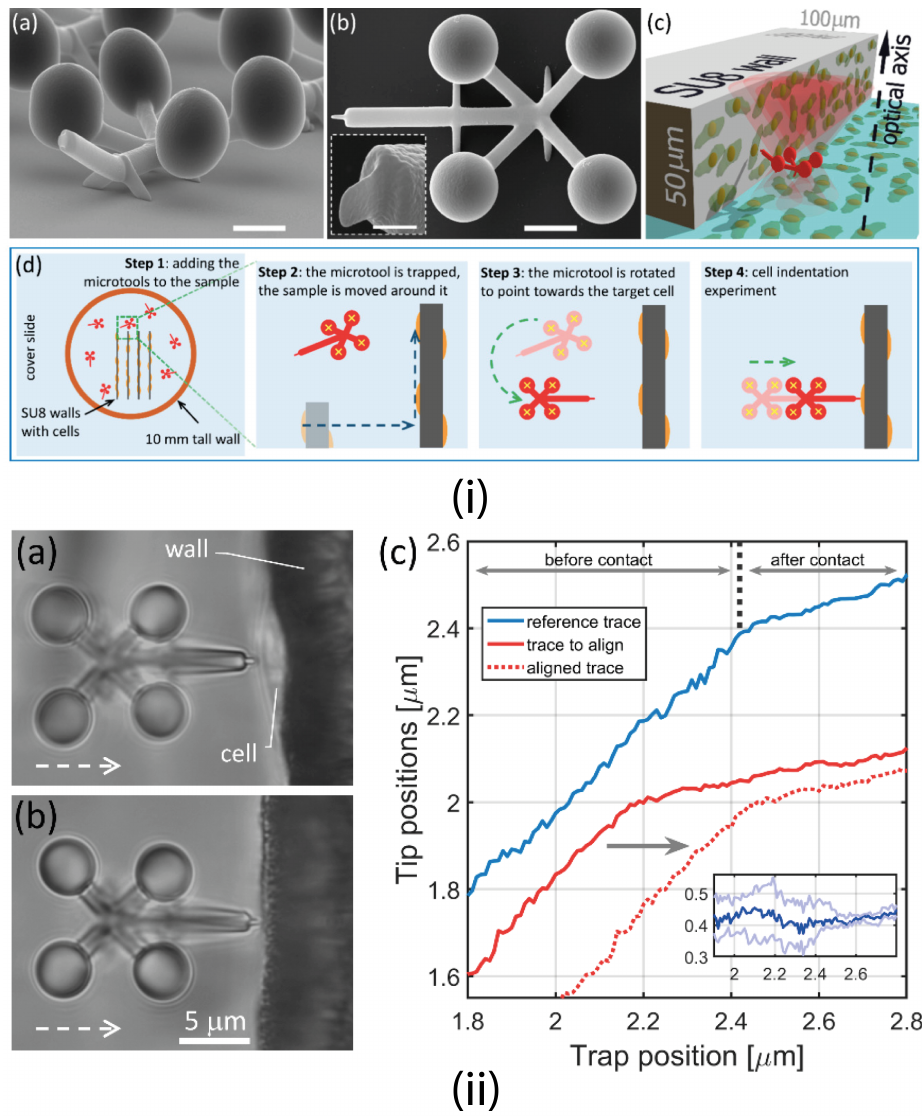
Figure 4. ( i ) The polymerized microtool and sample arrangement utilized in cell characterization studies. SEM images of the microtool from: ( a ) side view, ( b ) top view (scale bars: 5 m). It is clear that the tip and trapping spheres are on a separate plane from the rods that connect them. The inset in figure ( b ) depicts the tip of the microtool from the side (scale bar: 1 m), ( c ) 3D model view of the working of the microtool, and ( d ) steps involved in the maneuver of the microtool and indentation process. ( ii ) ( a,b ) Cell membrane indentation and characterization in action, and ( c ) displays the function of the trapping beam position on the tip positions from two cell indentation studies (solid blue and solid red lines). When the red line is aligned to the blue one using an alignment technique, it also displays the outcome of the trace alignment procedure (dashed red). The variations between the red and blue traces during the alignment process are displayed in the inset in ( c ) [86]. Reproduced under the terms of the CC-BY